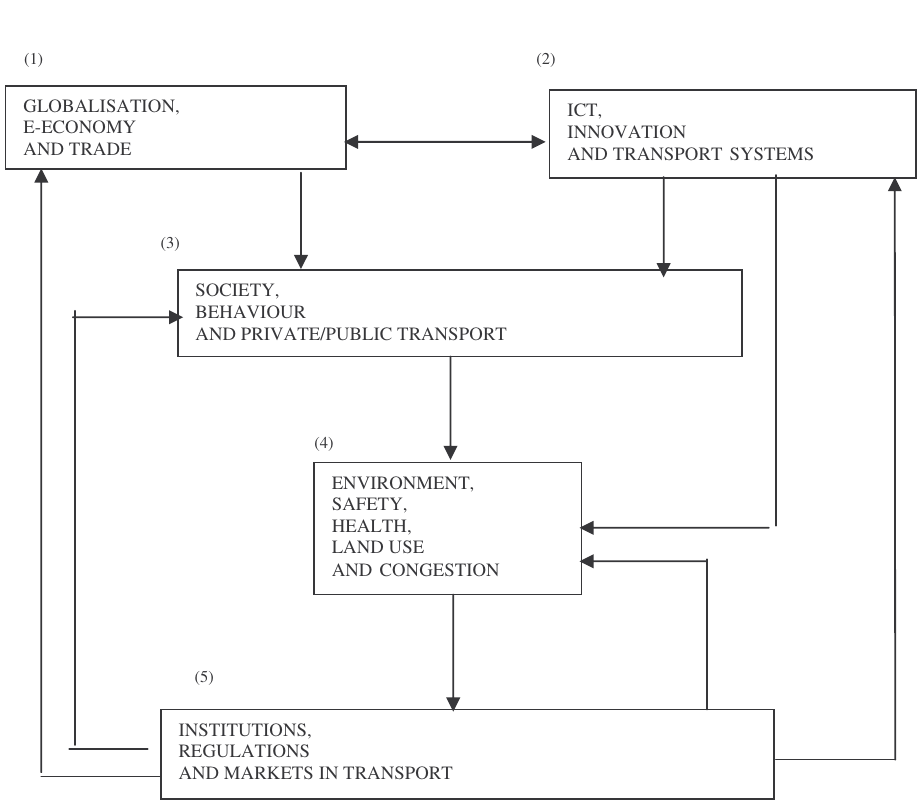
Figure 1. The complex force field of spatial